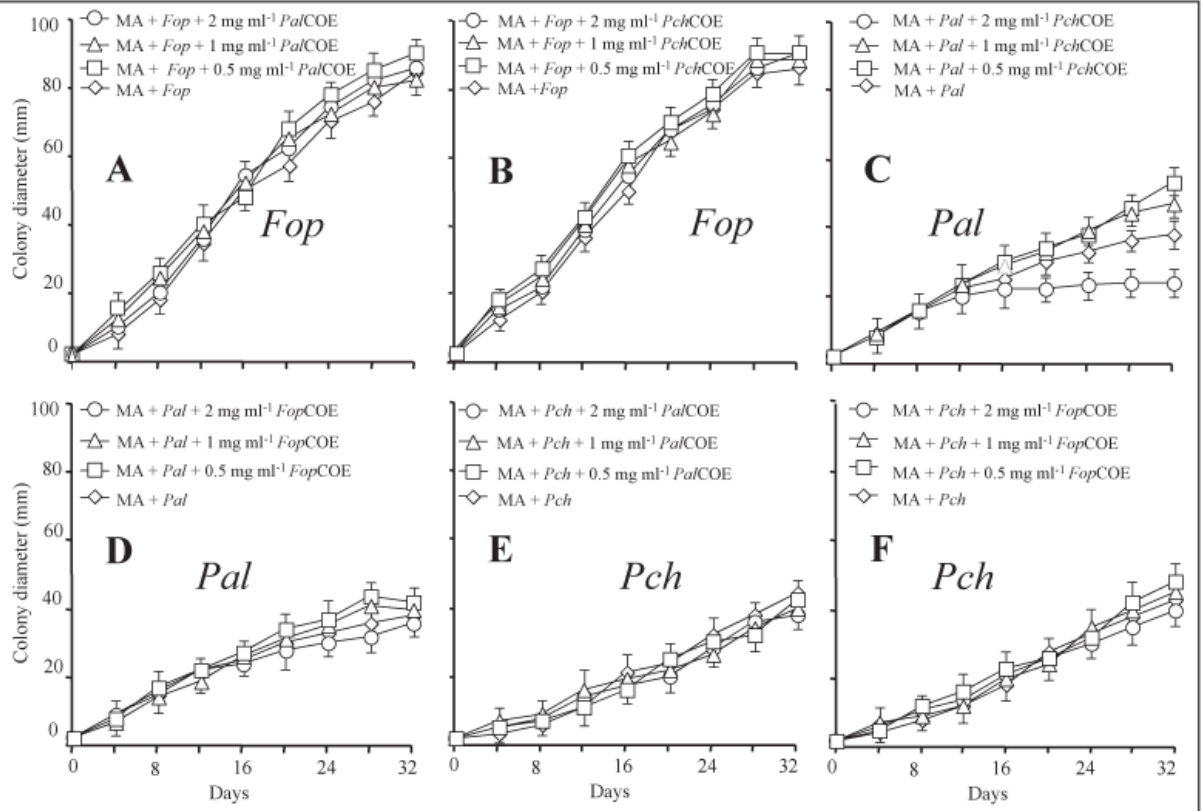
Fig. 3. Effect of crude organic extracts (COEs) of culture filtrates (CFs) of Fomitiporia punctata ( Fop ), Phaeoacremo- nium aleophilum ( Pal ) and Phaeomoniella chlamydospora ( Pch ) on the growth rate of each fungus: Fop with Pal- COE (A) or Pch COE (B); Pal with Pch COE (C) or Fop COE (D); Pch with Pal COE (E) or with Fop COE (F). Control: malt agar (MA). Cultures were grown in MA containing a cellulose thimble filled with 0.5 ml COE solution at concentrations ranging from 2 to 0.5 mg ml -1 . Standard error bars are